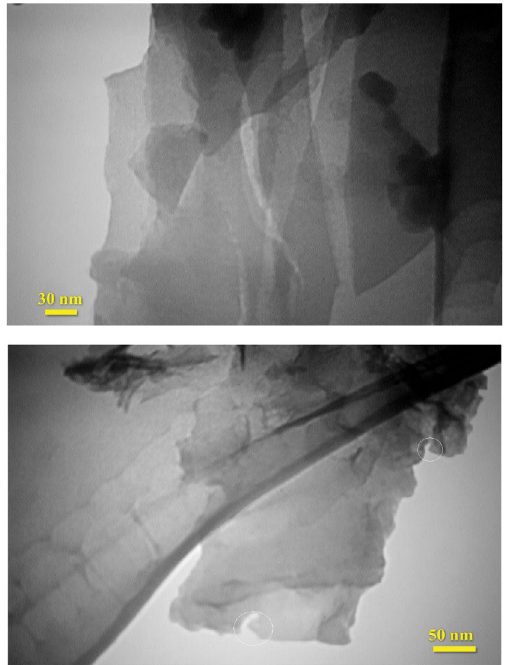
Fig. 6. TEM pictures of the a) CLP-Ni and b) D1.5 sample (external mesopores due to desilication procedure are indicated by circles.